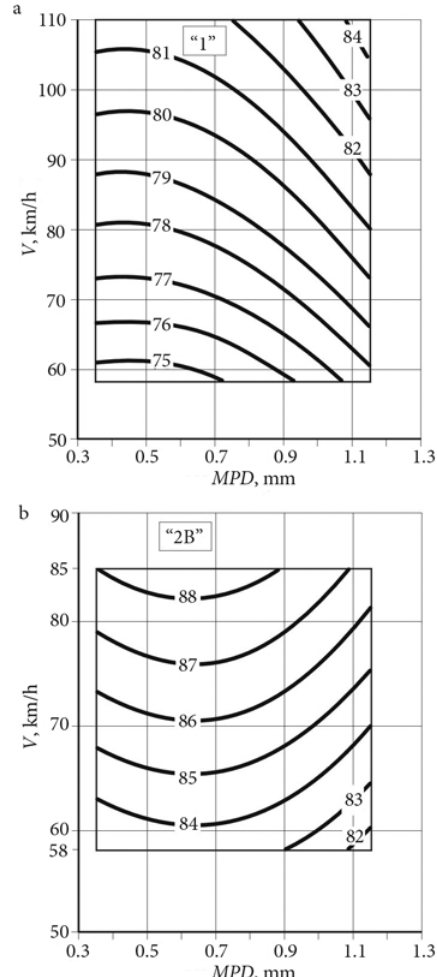
Fig. 6. Noise level as a function of macrotexture and speed of vehicle: a – passenger car (category “1”); b – multiple-axle heavy vehicle (category “2 B